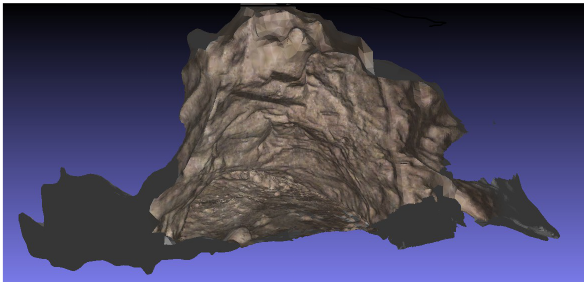
Figure 10. The textured 3D model.